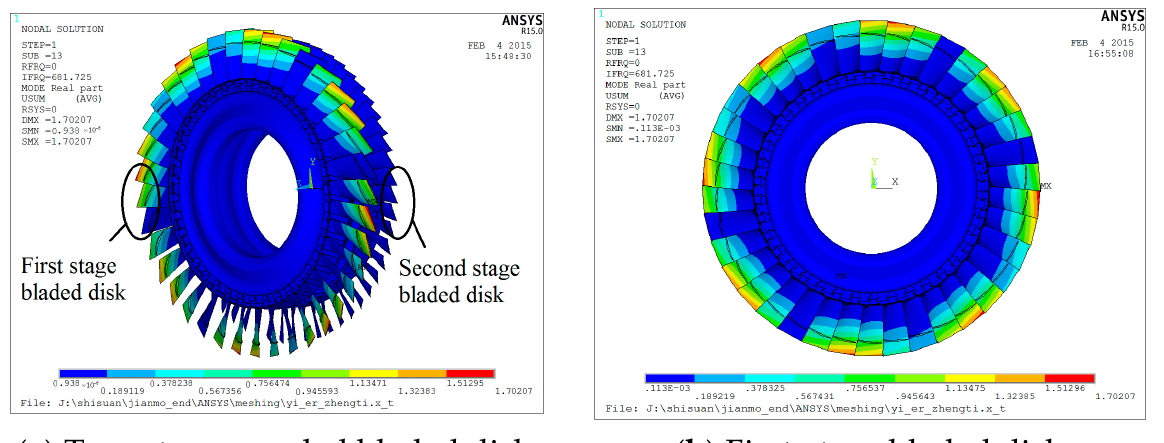
Figure 19. Four-pitch coupled vibration of the blade and disk.